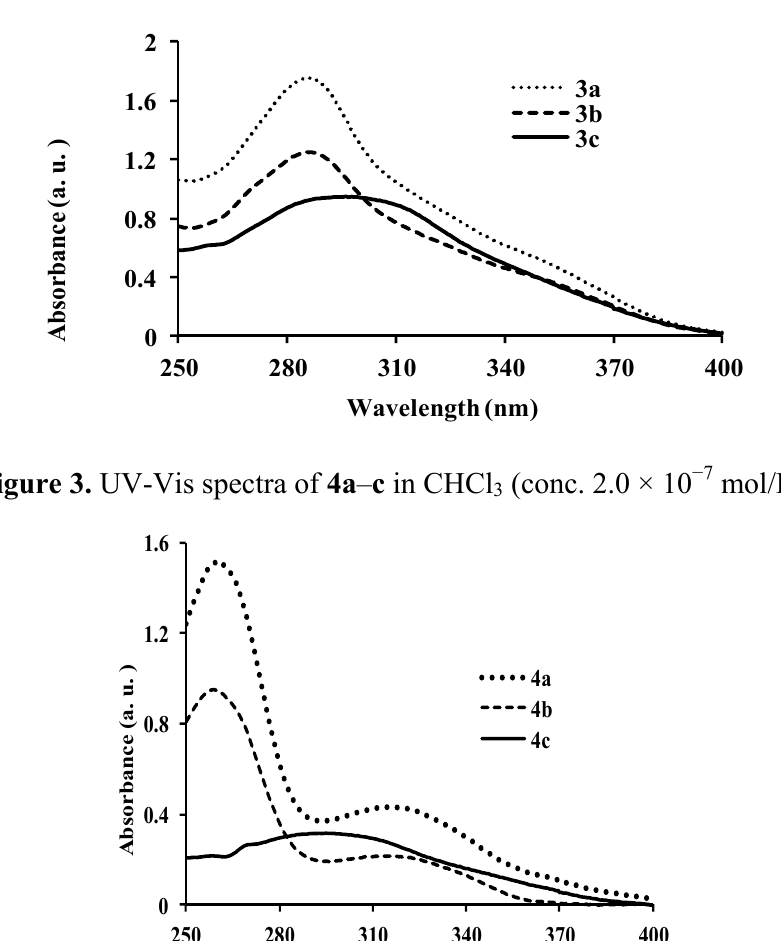
(conc. 2.0 × 10 − 7 mol/L). 3